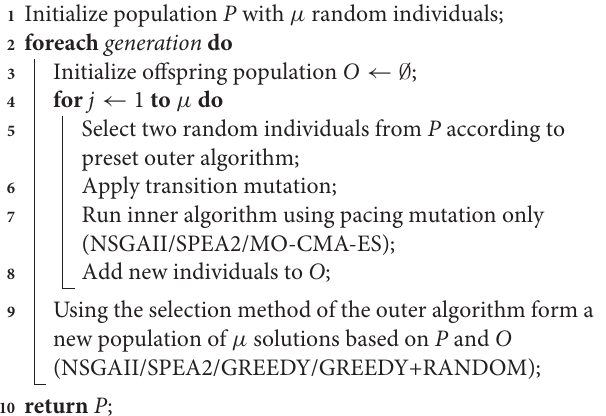
Algorithm 2: Framework of the Nested Multi-Objective Race Time optimization